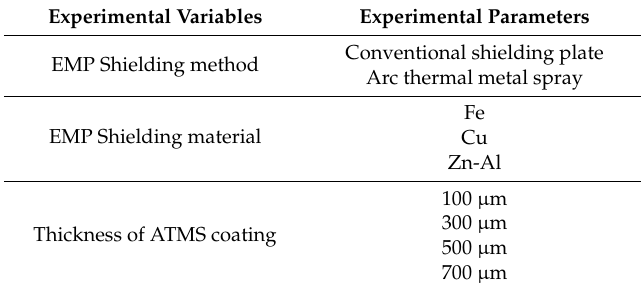
Table 1. Experimental variables for the evaluation of the shielding effectiveness (SE) test against EMP.